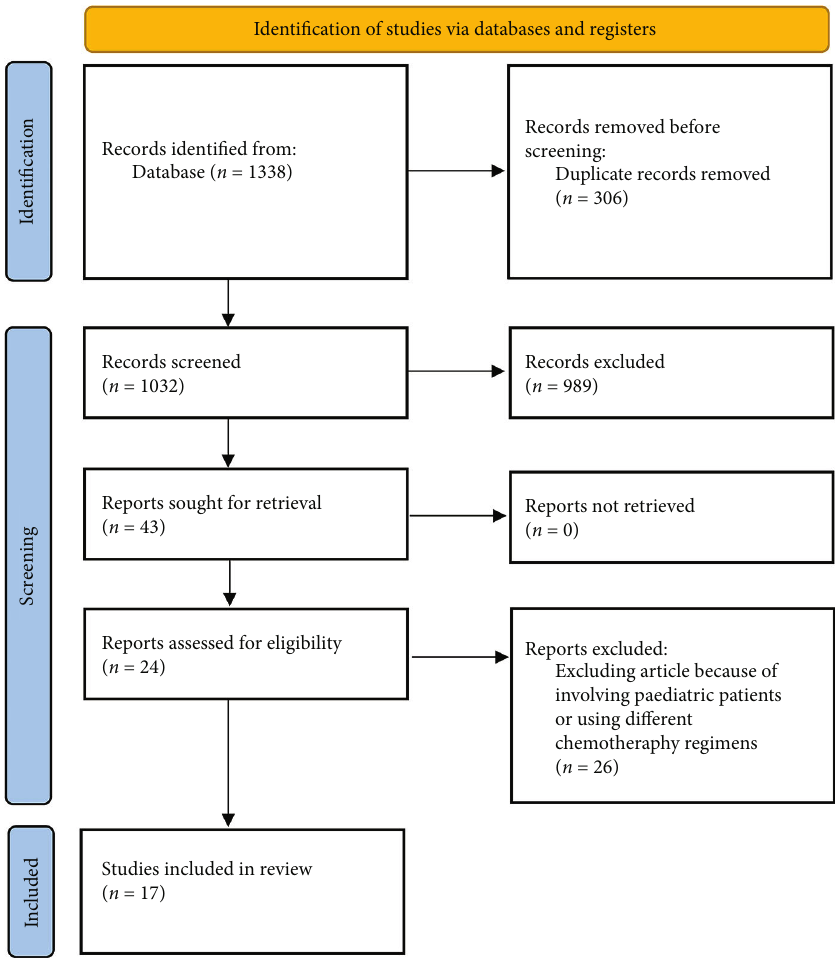
Figure 1: PRISMA fl ow diagram of